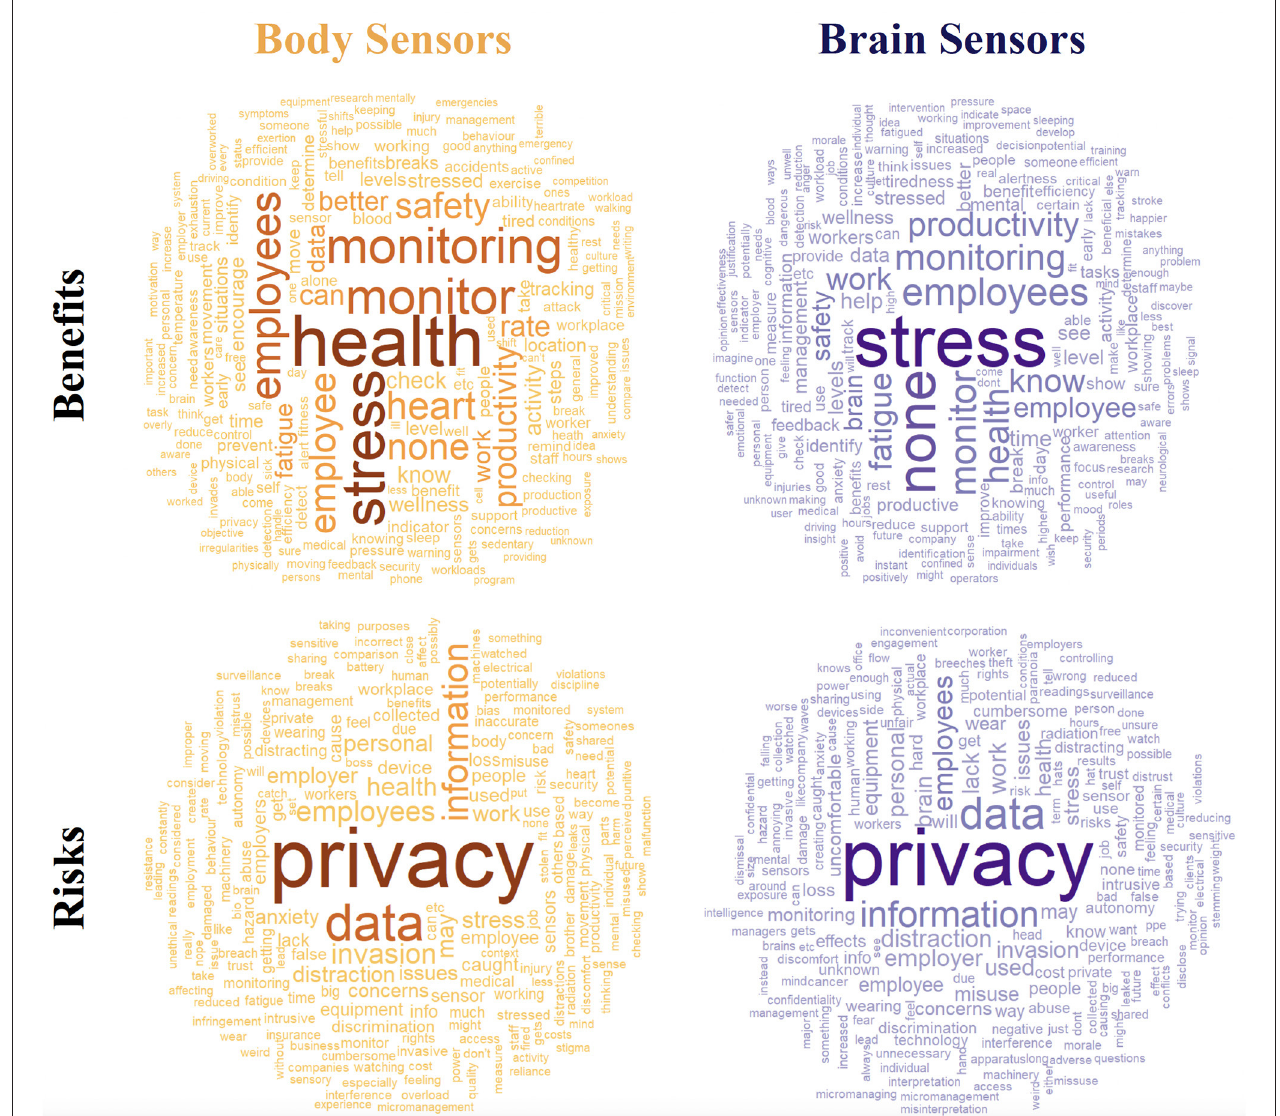
FIGURE 2 | Word clouds showing the perceived benefits and risks of body and brain sensors expressed by both Users and Implementers.